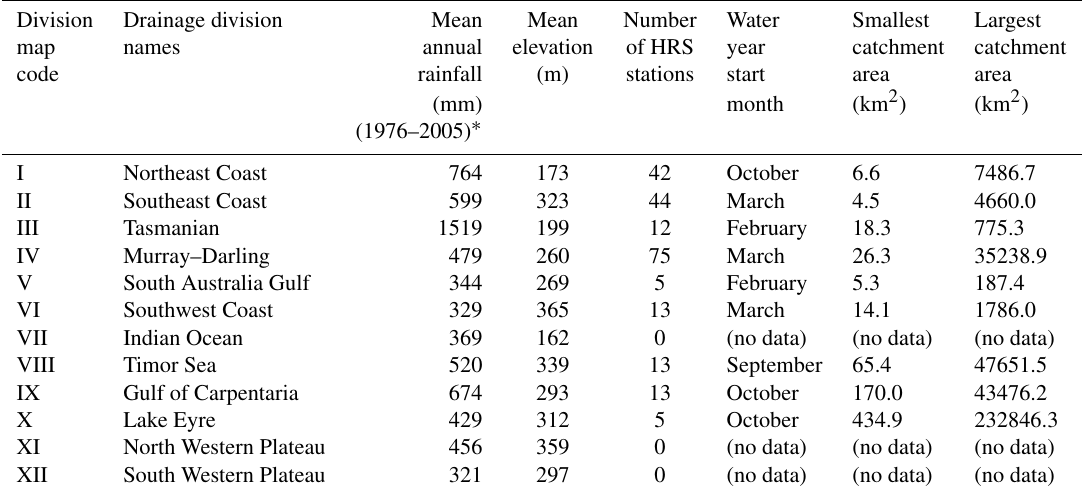
Table 1. Metadata of the drainage divisions and HRSs.